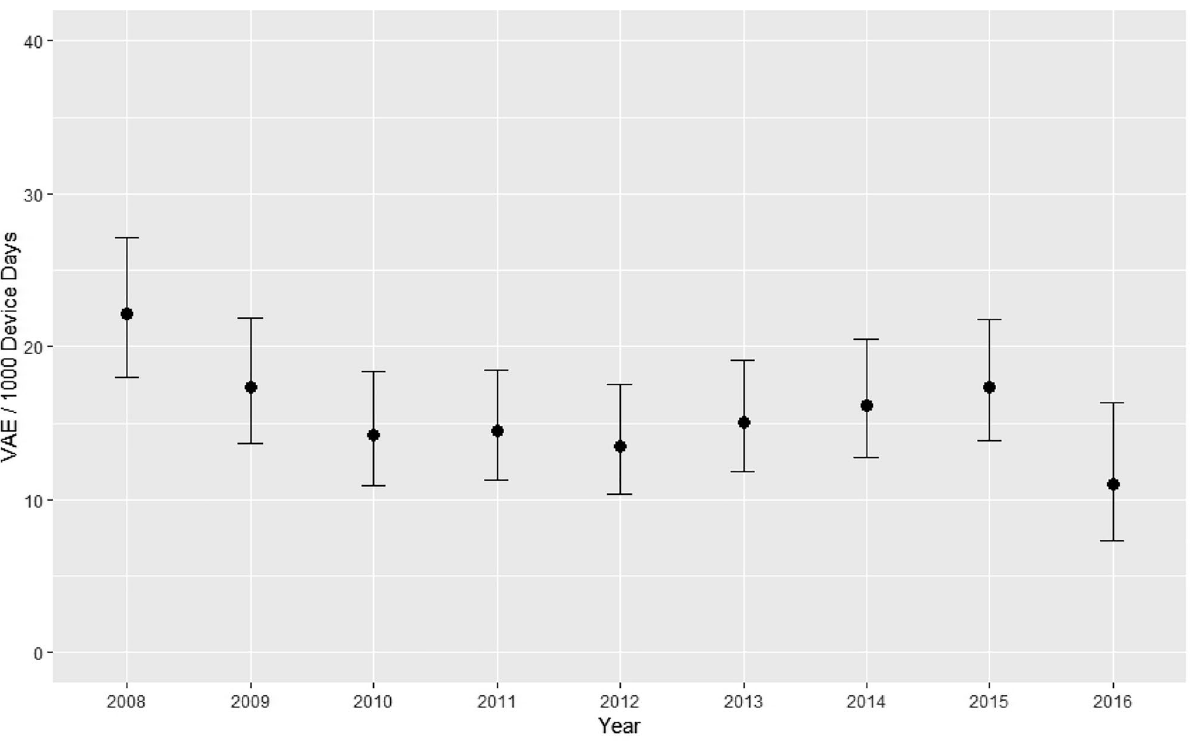
Figure 2. Incidence of VAE from 2008 to 2016. VAE Ventilator associated events.